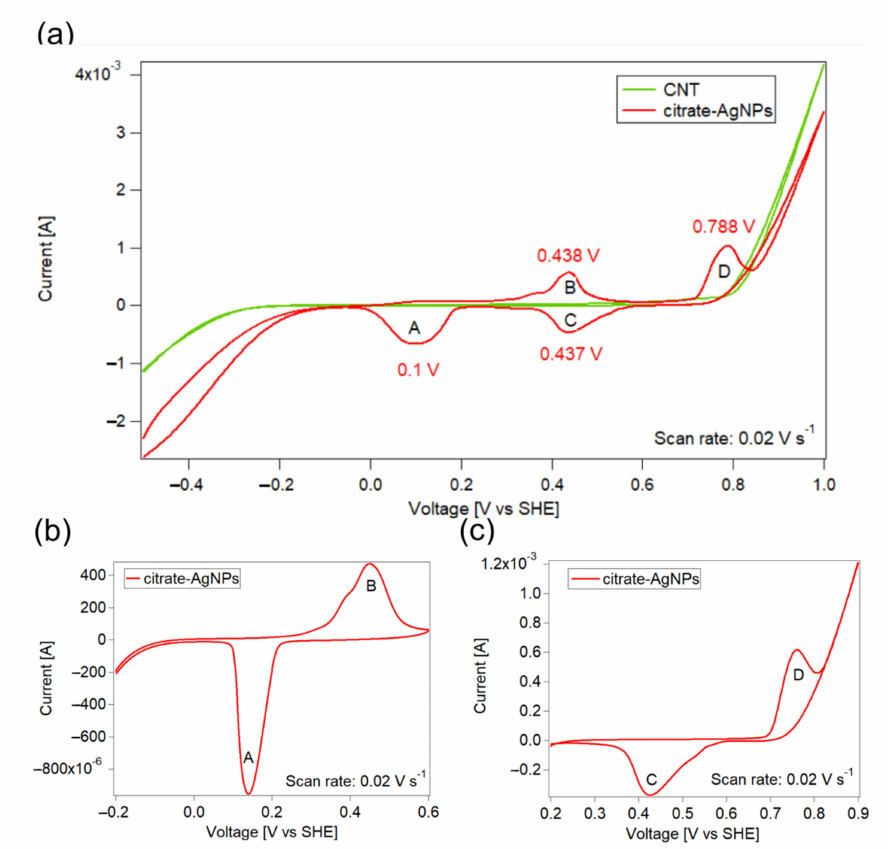
Figure 3. Cyclic voltammograms using citrate-AgNP-CNT electrodes. ( a ) Comparison with CNT electrodes (without silver), showing the 0.0–0.8 V window of the CNT electrode and the reactions promoted by citrate-AgNPs, peaks A through D; ( b ) voltammogram in the range − 0.2–0.6 V, showing only peaks A and B, corresponding to silver reduction and oxidation peaks; ( c ) voltammogram in the range 0.2–0.9 V, showing only peaks C and D, corresponding to oxygen evolution and reduction peaks. The absence of peak C in ( b ) and of peak B in ( c ) indicates that the pairs C/D and A/B correspond to two independent redox reactions. In all cases, the scan rate was 0.02 V s − 1 and the electrolyte used was 0.1 M KOH. Voltages are given with respect to the standard hydrogen electrode. There was no degassing using N 2 nor another